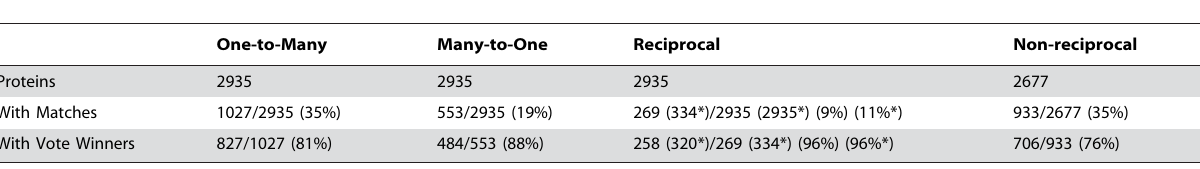
Table 7. ETA Annotation of the Structural Genomics Unannotated